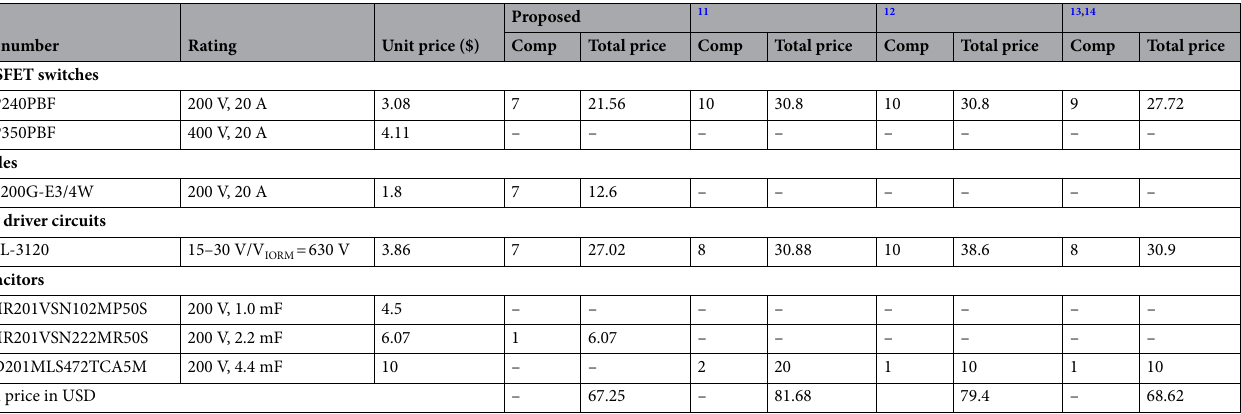
Table 7. Cost comparison for proposed topology with other similar topologies 11–14 .